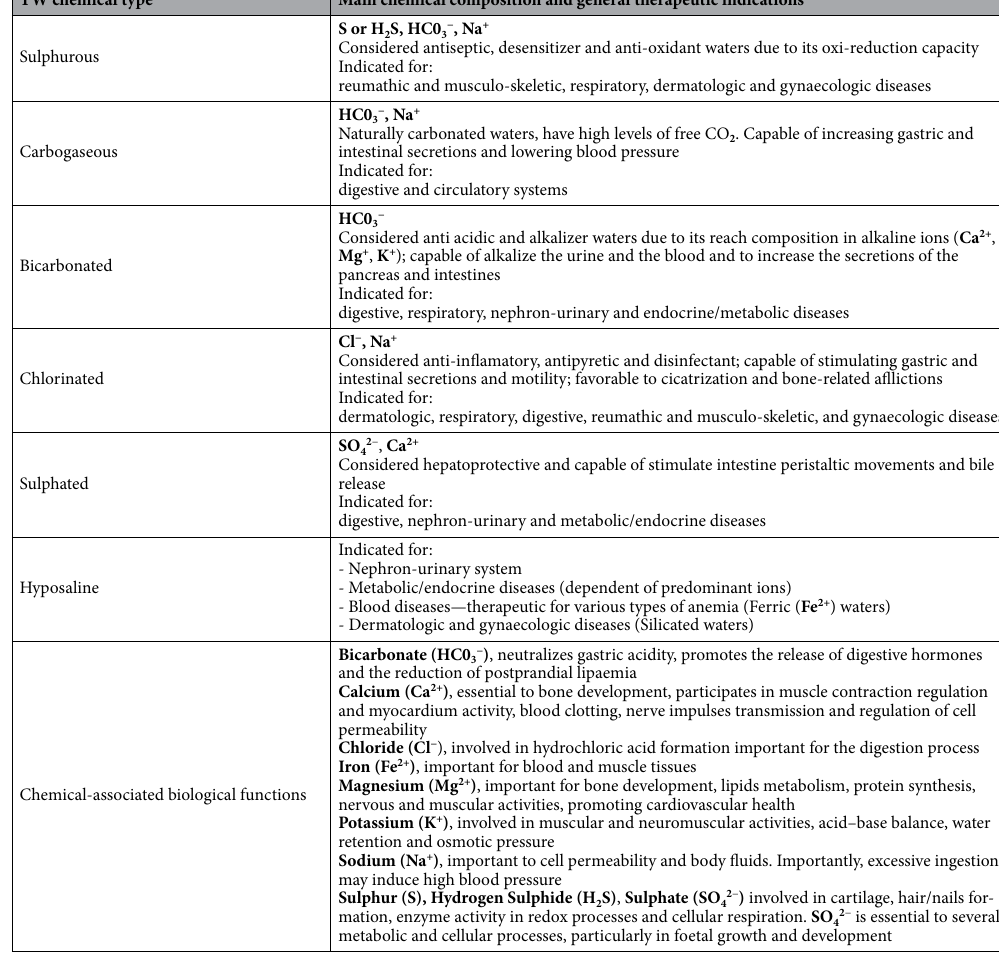
Table 1. TW chemical types, main chemical content and therapeutic indications. Examples of chemical- associated biological functions are given. Adapted from 4,5,8